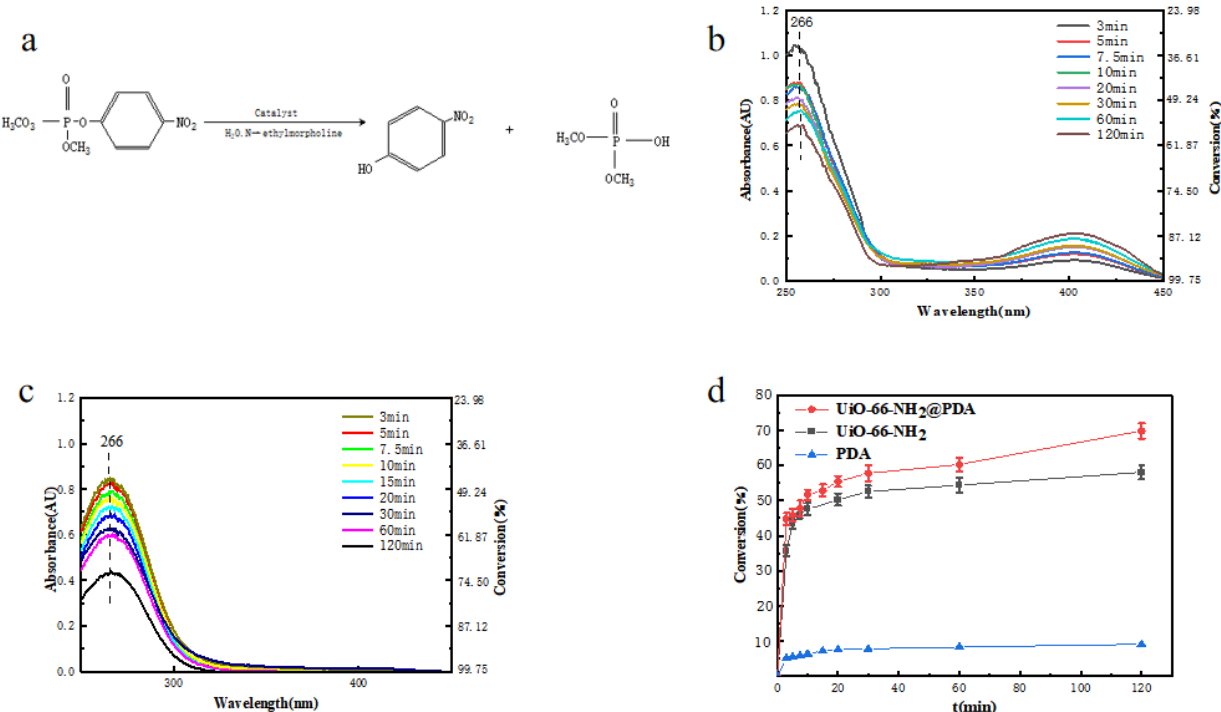
Figure 6. ( a ) Catalytic hydrolysis mechanism of DMNP; ( b ) UV–vis spectra of the degradation of DMNP with UiO-66-NH 2 at room temperature; ( c ) UV–vis spectra of the degradation of DMNP with UiO-66-NH 2 @PDA at room temperature; ( d ) UiO-66-NH 2 , PDA, and UiO-66-NH 2 @PDA degradation of DMNP conversion rate under the same conditions comparison.